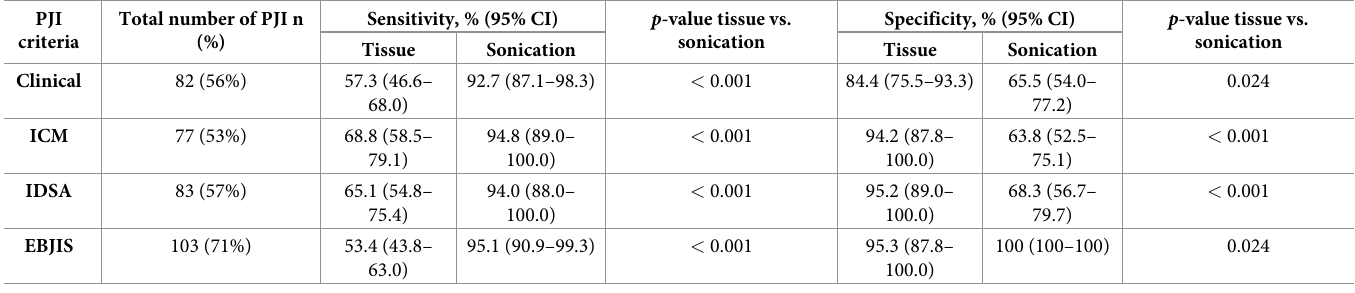
Table 2. Description of PJI cases according to different criteria, sensitivity and specificity of tissue and sonication cultures in 146 patients undergoing prosthetic joint revision. PJI